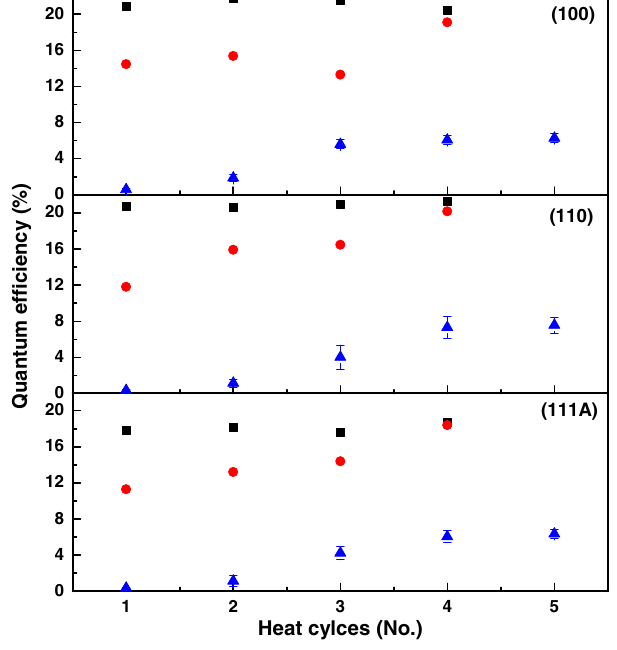
FIG. 8. QE versus heat cycles for bulk GaAs with three different surface cleave planes. Black square: no implantation; red circle: implantation with 100 V hydrogen ions; blue triangle: implantation with 10 000 V hydrogen ions. Errors for no implantation and 100 V results are small because QE was uniform across sample; errors for 10 000 V results are large because ion damage was limited to small region of photocathode.